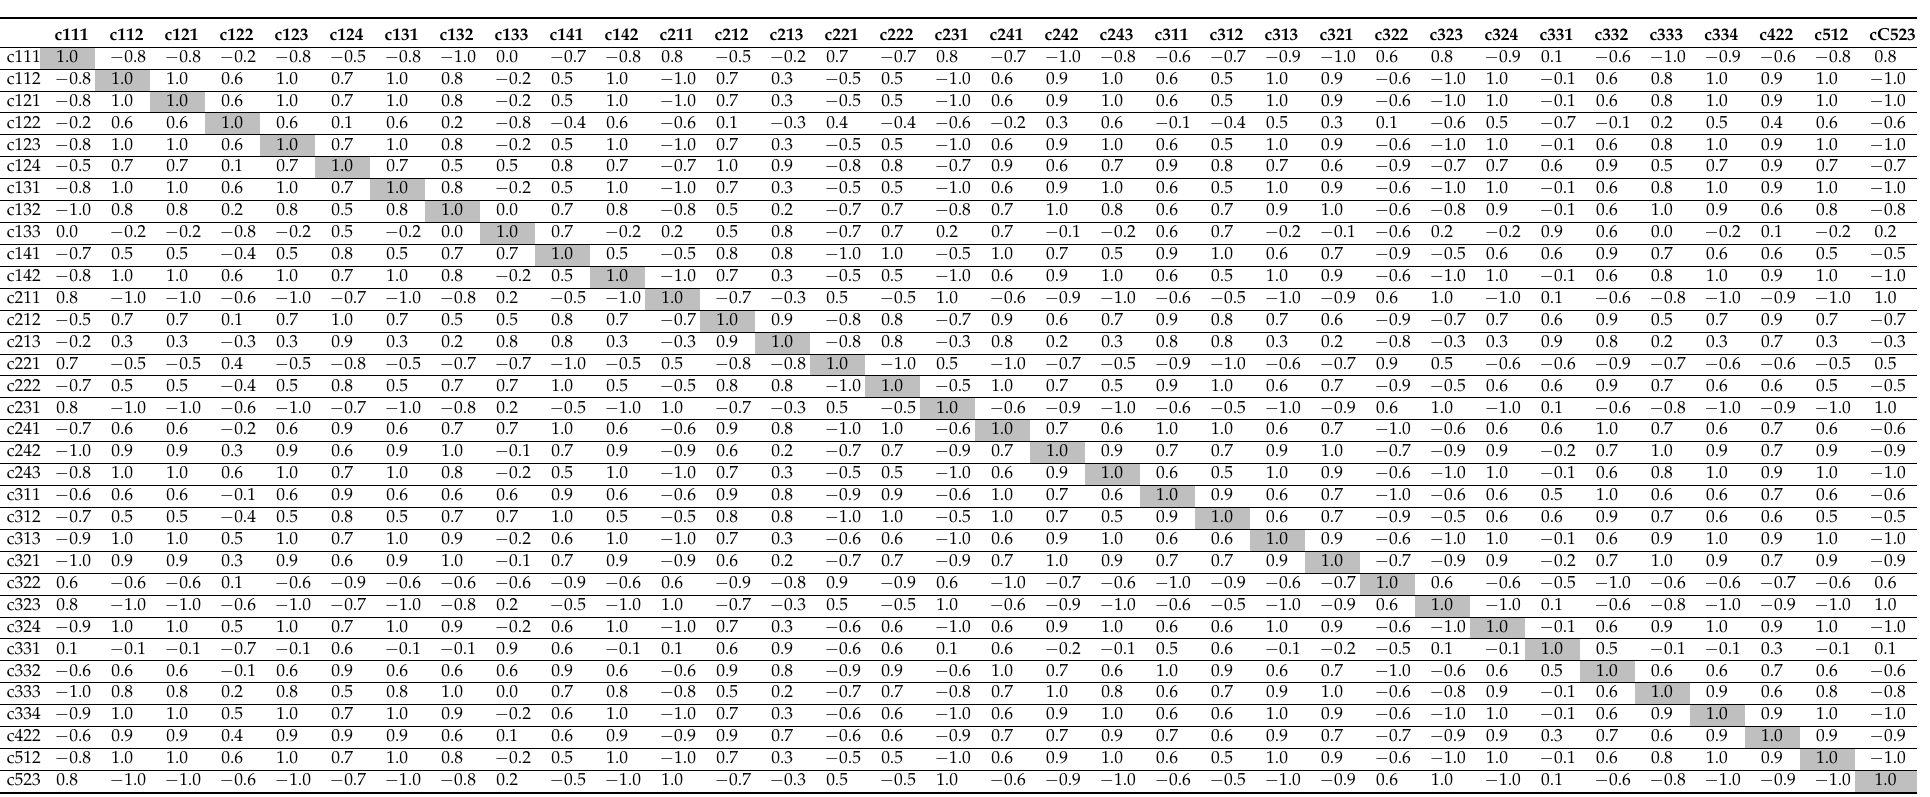
Table A3. Spearman’s rank correlation coefficient values in the Canary Islands archipelago for land-uses at level 3 according to the CLC nomenclature between 1990 and